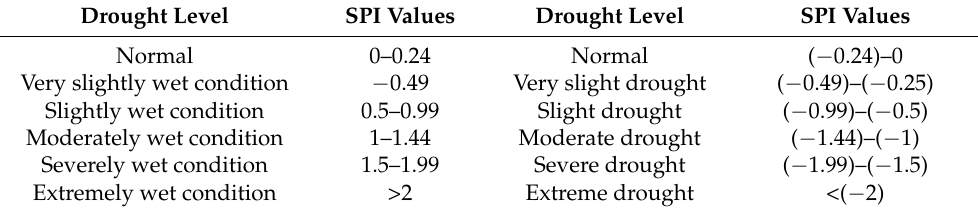
Table 1. Vietnam’s SPI-based classification of the drought includes the category and value. Drought